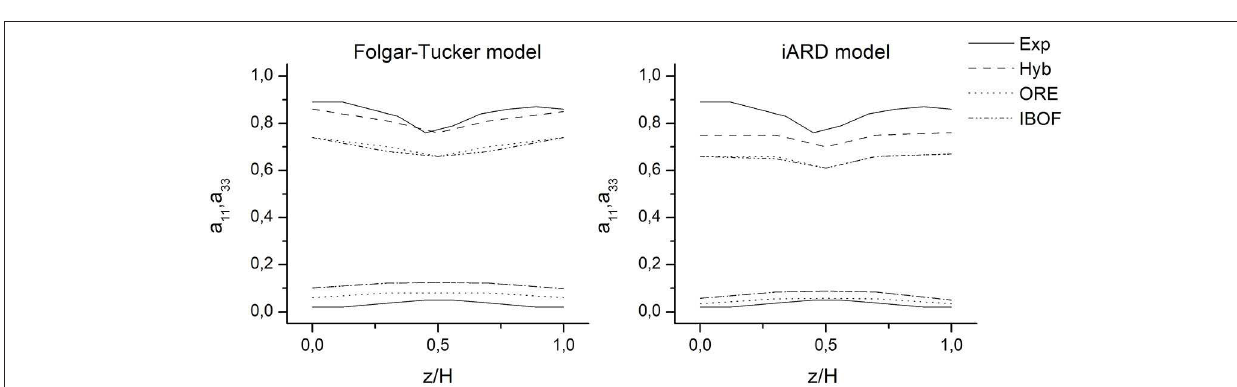
FIGURE 4 | Experimental and predicted a 11 and a 33 profiles at the entrance region (R1).